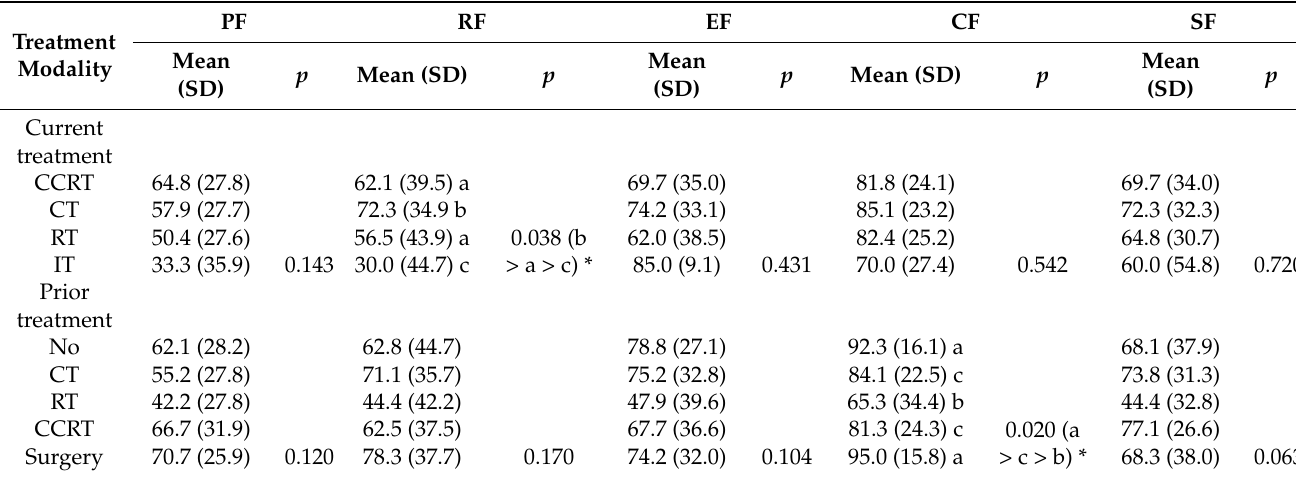
Table 2. Association between treatment modality and